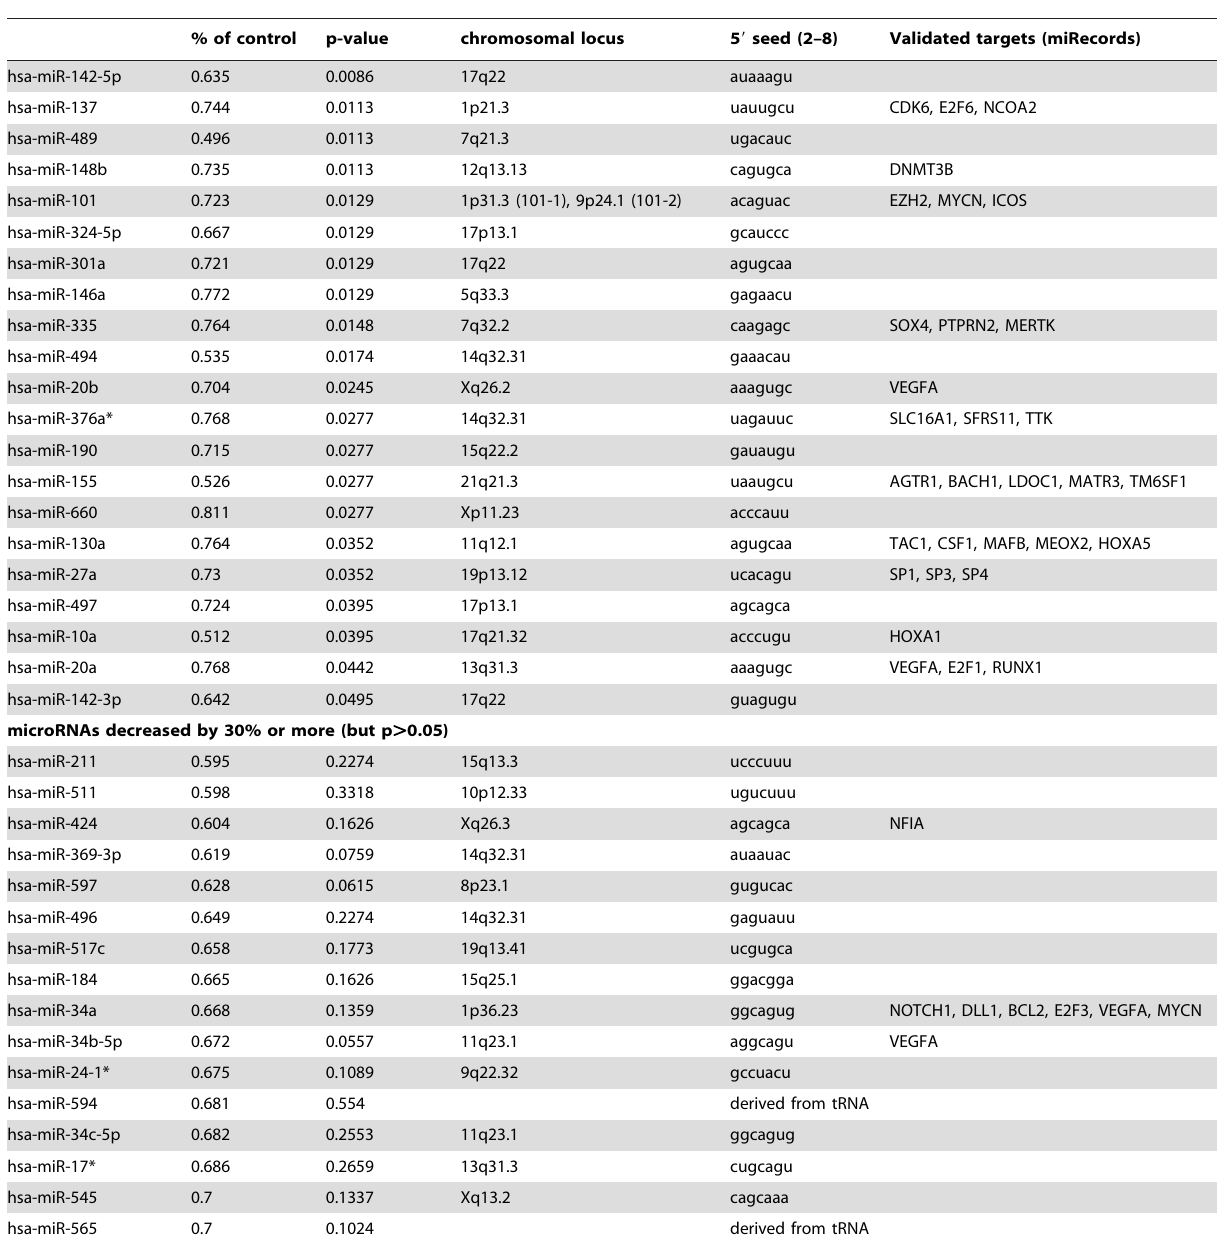
Table 2. microRNAs down-regulated in depressed suicide as determined by individual tests of statistical